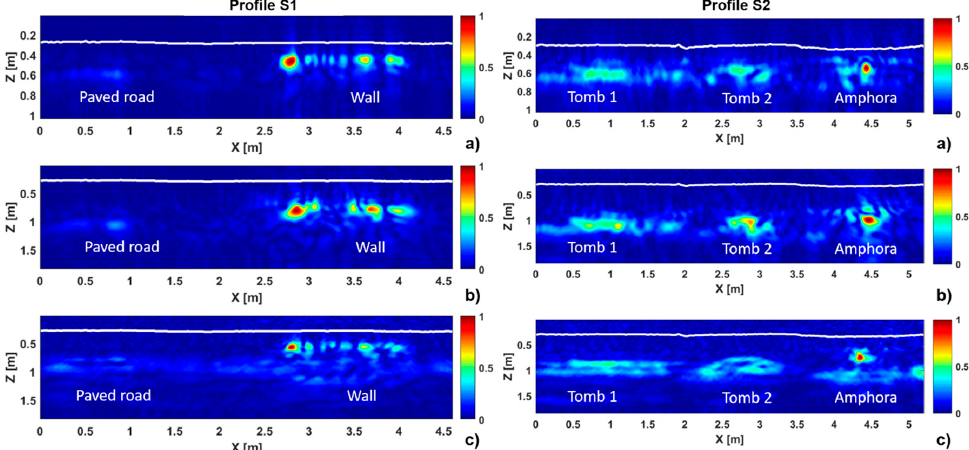
Figure 11. Tomographic images for each profile S1 ( left panels ) and S2 ( right panels ); panels ( a – c ) show the tomographic reconstruction obtained with relative permittivity of the freshwater ( ε w ) , the wet sand ( ε ws ) , and the equivalent one (cid:0) ε wseq (cid:1) , respectively. The white lines represent the estimated bathymetry profiles. The tomographic images show the normalized intensity of the retrieved contrast. It is worth pointing out that, according to the Born approximation and the reflection measurement configuration adopted here, we are able to provide the information about the upper and lower sides of the targets along the z -axis, and then their vertical extension. Note that, while an accurate reconstruction of the upper side of the targets is always expected, a shift of the actual on the vertical spatial resolution. Moreover, the reconstructed images can be affected by ghosts due to the occurrence of multiple interactions, which are not accounted for in the approximated scattering model adopted to formulate the imaging [38]. In addition, the considered data are affected by an undesired spurious signal, which represents a replica due to the freshwater-wet sand interface (see Figure 10) and affects the tomographic images, especially for the profile S1. 4. Discussion The results presented into the previous section corroborate that the use of microwave tomography allows us to obtain focused images of the investigated scenario, which provide precise indication about location and size of the buried objects detected in the raw radargrams of Figure 6. On the other hand, by comparing the three reconstructions shown on the left and right panels of Figure 11, one can observe that the use of a constant value for the dielectric permittivity of the investigated medium provide a less accurate localization of the objects both along the (cid:1850) -axis and the (cid:1852) -axis compared to the one obtained by considering a variable permittivity. In particular, we can observe that by facing the imaging problem according to the mathematical model based on the concept of equivalent permittivity it is possible to have an improved estimation both of the object size along the X -direction and estimation of their depth. In order to support this statement, in Figure 12 left and right panels, awe reported the binary images with superimposed the boundaries of the true targets of the retrieved contrast functions referred to S1 and S2 profiles, respectively. These binary images have been obtained by using a thresholding procedure that considers as noise or artefacts the values of the amplitude of the retrieved contrast that are lower than 30% of its maximum value in the tomographic image. It is worth noting that, as far as profile S1 is concerned, since the paved road is masked by the wall, it is not detected in left panels of the binary images in Figure 12.